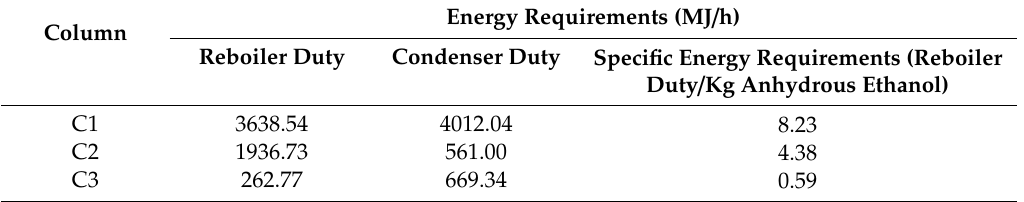
Table 6. Energy requirements.